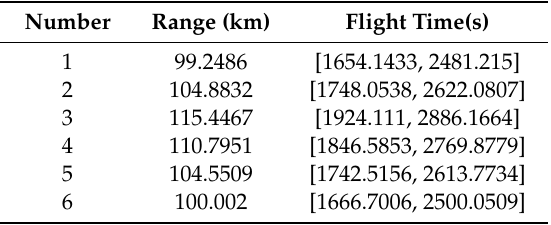
Table 16. Range and flight time of each aircraft (case 4).